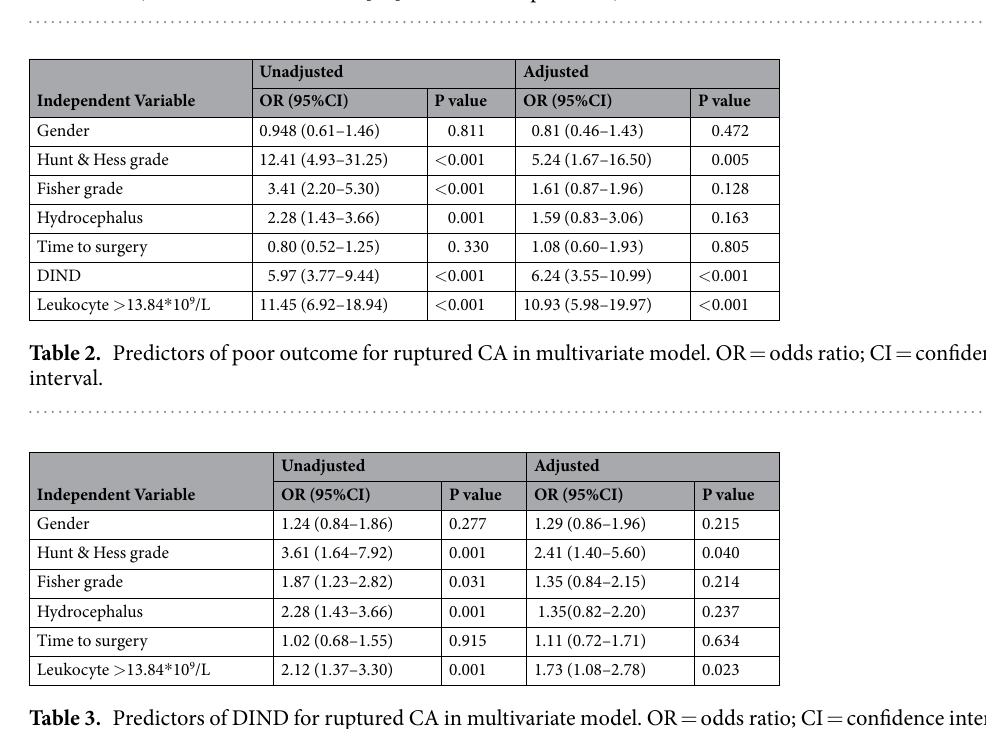
Figure 1. Predictive values of leukocyte count for the 3- month modified Rankin Scale(mRS) > 3 Area under curve 0.787 (95% confidence interval [CI], 0.745–0.825; p < 0.001).